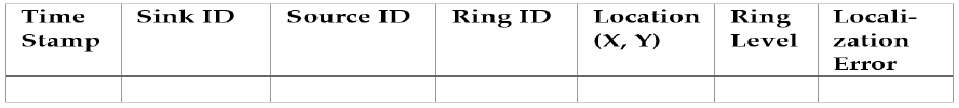
Figure 3. Mobile sensor network with the different categories of nodes.